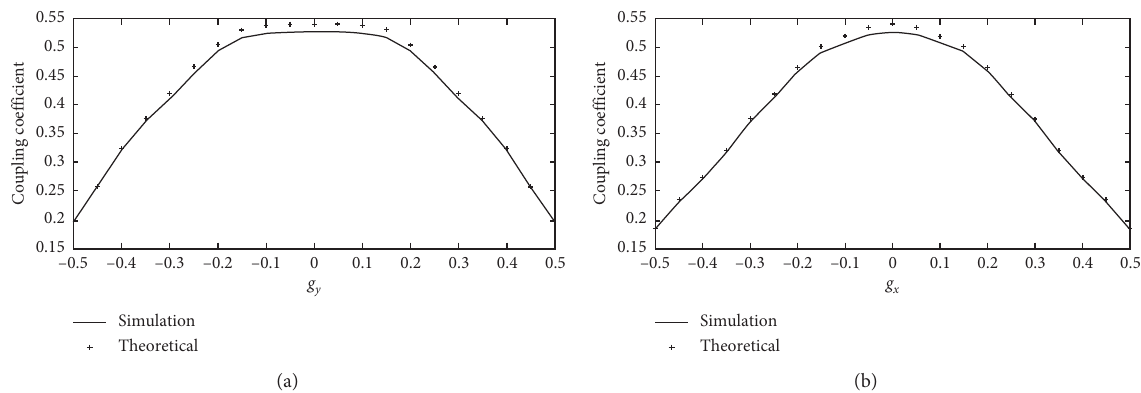
Figure 9: Coupling coefficient of horizontal offset of the secondary coil. (a) Offset along the long side. (b) Offset along the short